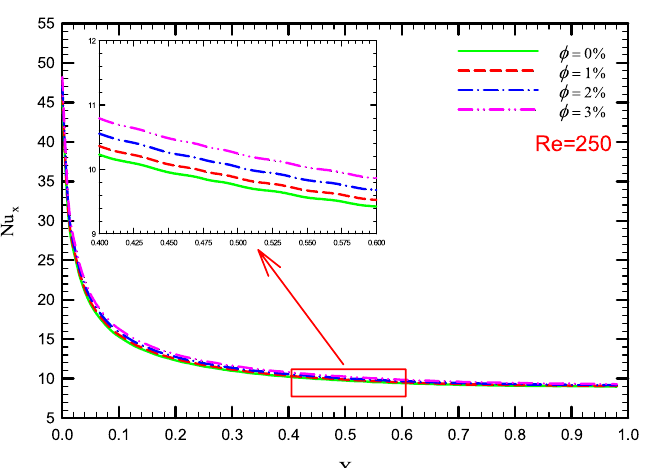
Figure 19. Nu x versus dimensionless length in Re = 250 for Case 3.